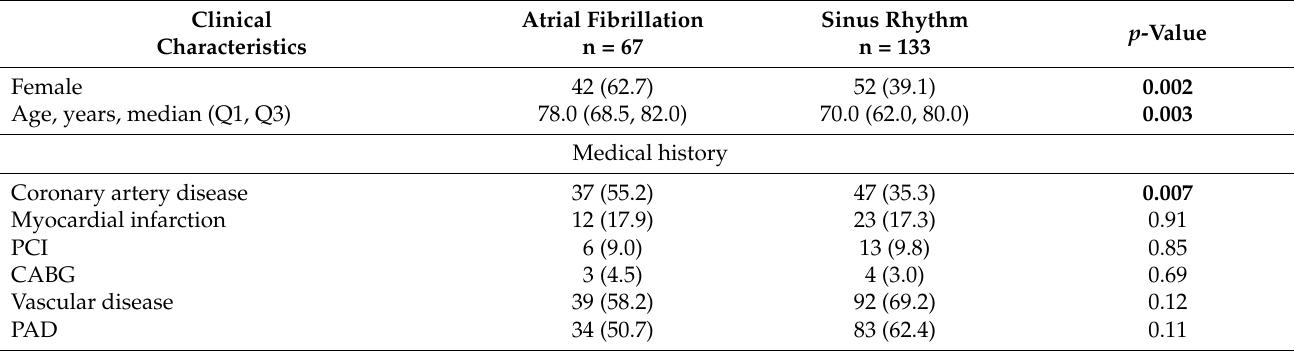
Table 1. Characteristics of study